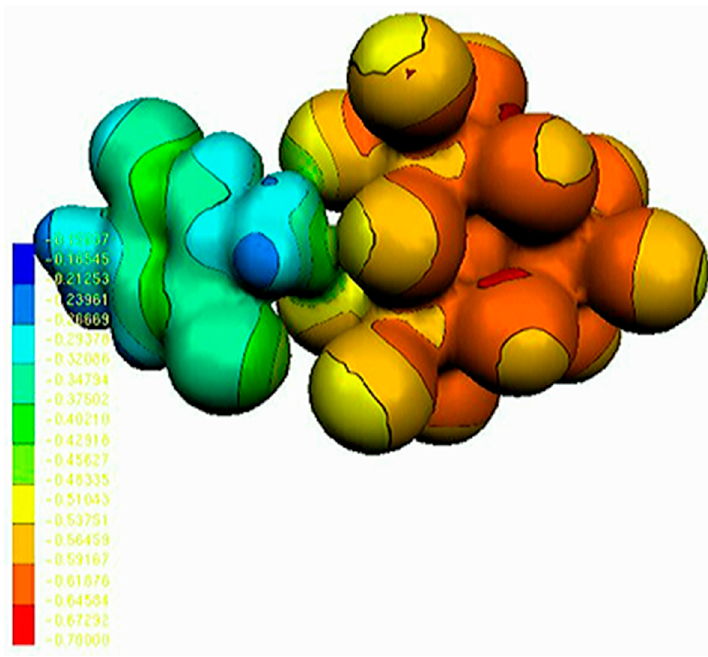
Figure 13. TheDOS spectrum of(C 6 H 8 Cl 2 N 2 ) 2 [Cd 3 Cl 10 ]·6H 2 O.